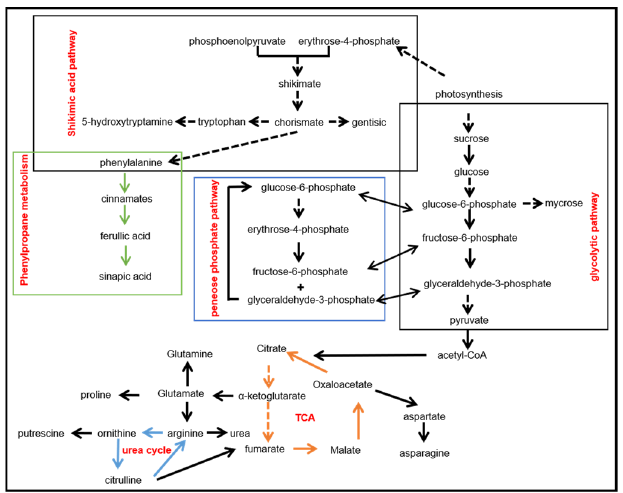
Figure 2. Metabolic pathways involved in salt stress. Blue numbers indicate related references.